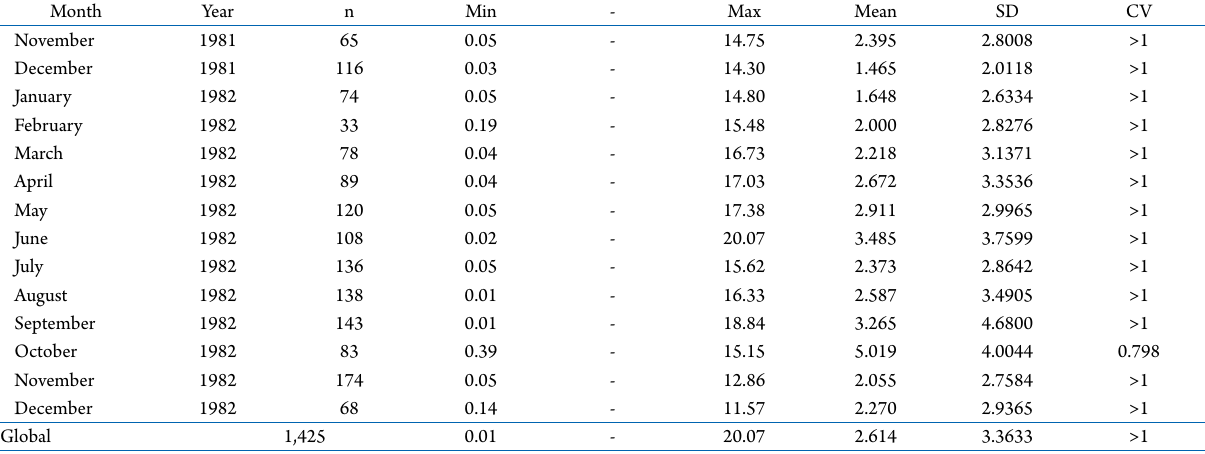
Table 2. Average monthly weight (g) of the Parastacus nicoleti